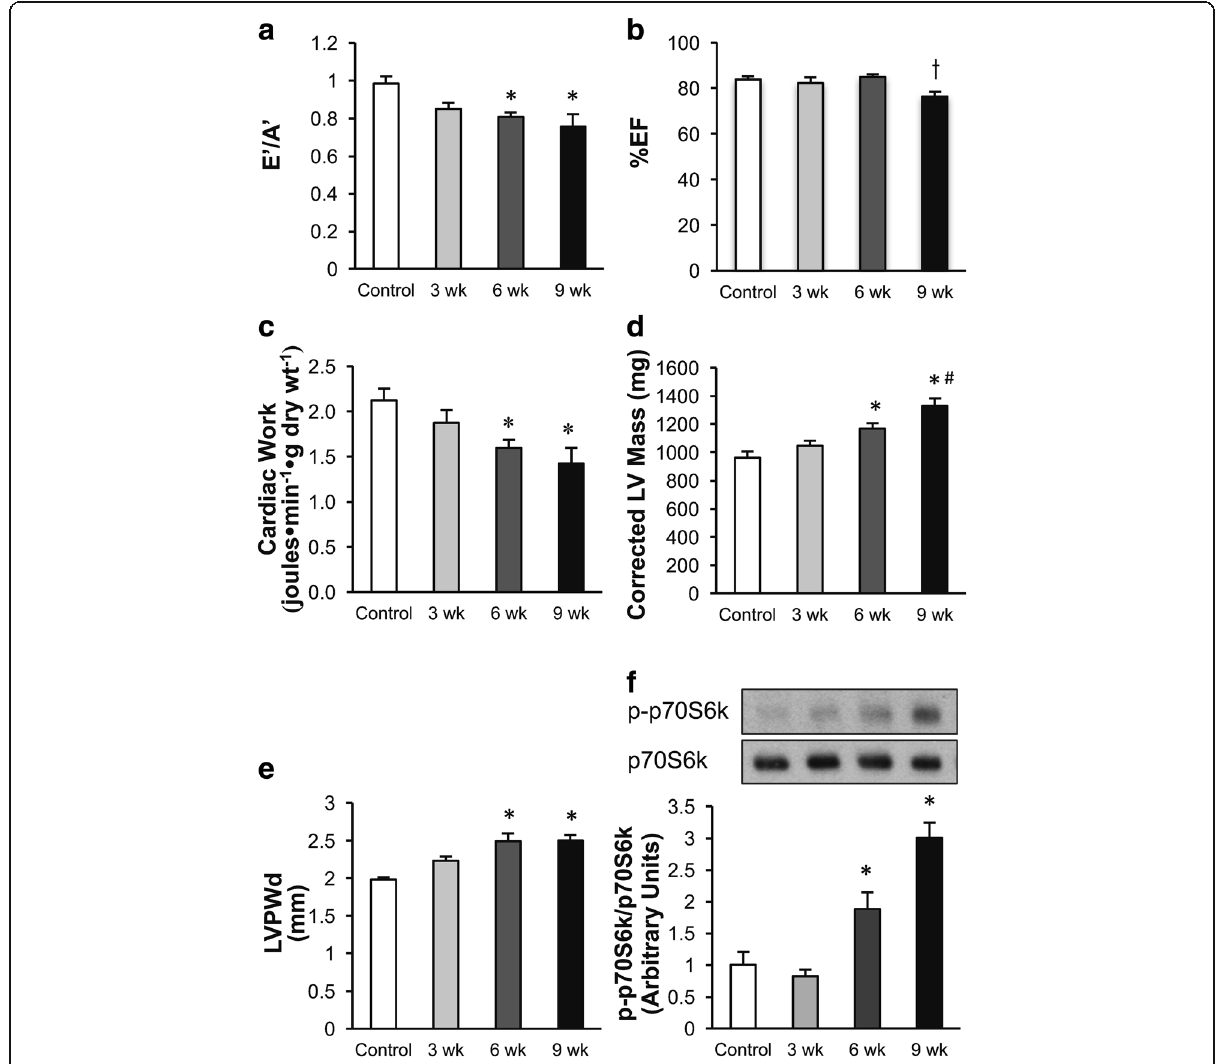
Fig. 1 Time dependent effects of a high salt diet (HSD) on Dahl salt-sensitive rat cardiac function and hypertrophy. a Diastolic dysfunction was measured by E ’ /A ’ . b %EF was measured by echocardiography. c Cardiac work was measured during the isolated working heart perfusions. d-e Cardiac hypertrophy was measured by corrected LV mass and LVPWd using echocardiography. f Cardiac p-p70S6K/p70S6K protein expression was assessed in hearts obtained at each of the time periods studied. Measurements were made in Dahl salt-sensitive rats fed a low salt diet, 0.3% NaCl (Control) or a HSD, 8% NaCl, for 3, 6, or 9 weeks. n=5 – 8 * p <0.05 compared to Control. # p <0.05 compared to 3 weeks. t p <0.05 compared to 6 weeks. Values shown as mean ±